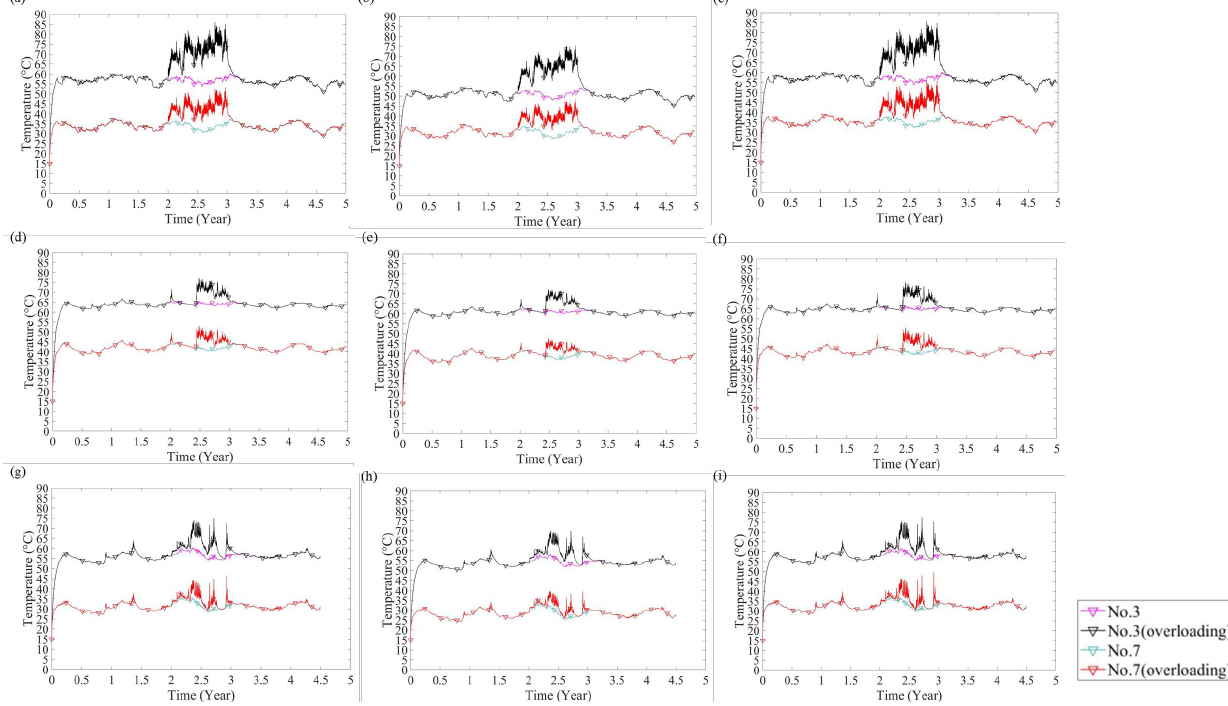
Figure 11. Temperature comparisons: backfill of BRU location ( a ) B1 ( b ) LSS ( c ) FSL; LT location ( d ) B1 ( e ) LSS ( f ) FSL; DP location ( g ) B1 ( h ) LSS ( i ) FSL.